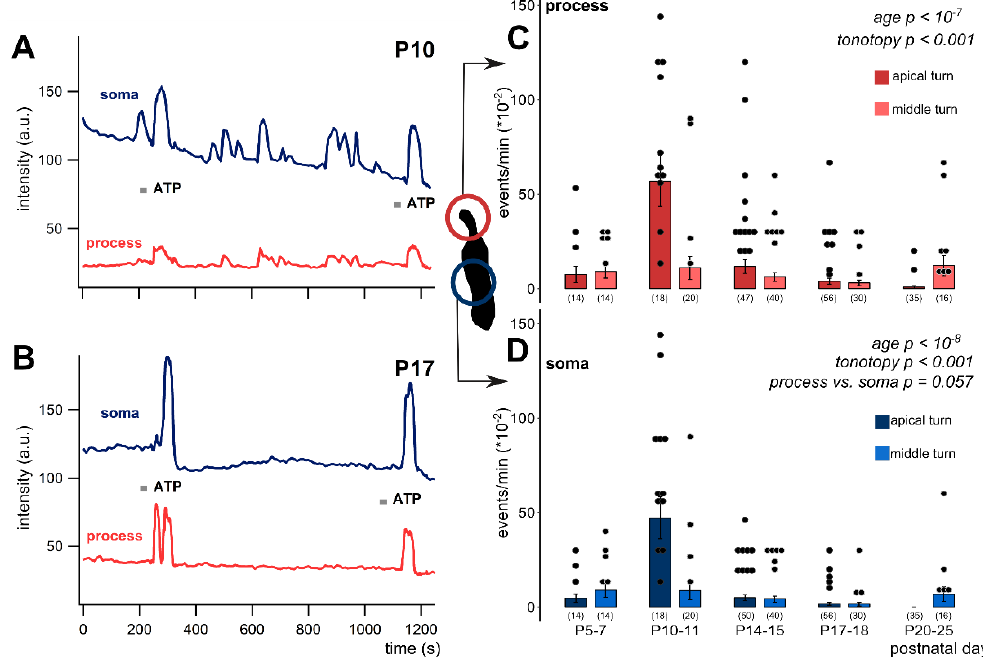
Figure 2. Age-dependent spontaneous Ca 2+ activity in the apical and middle cochlear turn Deiters’ cells in the mouse hemicochlea preparation. Representative traces from apical turn cells demonstrate the remarkable difference in activity of the intracellular Ca 2+ events at P10 ( A ) vs. P17 ( B ). Short grey lines indicate ATP application in the perfusion (100 µM, 30 s). Event activity of individual cells and averages of the activities by age are shown in the apical and middle turns in the phalangeal process ( C ) and the soma ( D ) of the Deiters’ cells. Spontaneous activity decreased significantly by age from P10-11 in both subcellular compartments. There was a prominent increase at P10-11 in the apical turn. The tonotopic difference was significant in both the process and the soma. The difference between the subcellular compartments was tendentious, i.e., the processes had higher event rate at all ages. Bars show mean ± SEM and the black dots indicate individual measurements. Values of zero (no spontaneous activity) were removed for clarity (high number of dots). Number of experiments are in parenthesis. Respective p values, showing the significance of age or turn differences or the process vs. soma difference are written in italics. Details of statistical analysis are given in the Materials and Methods.